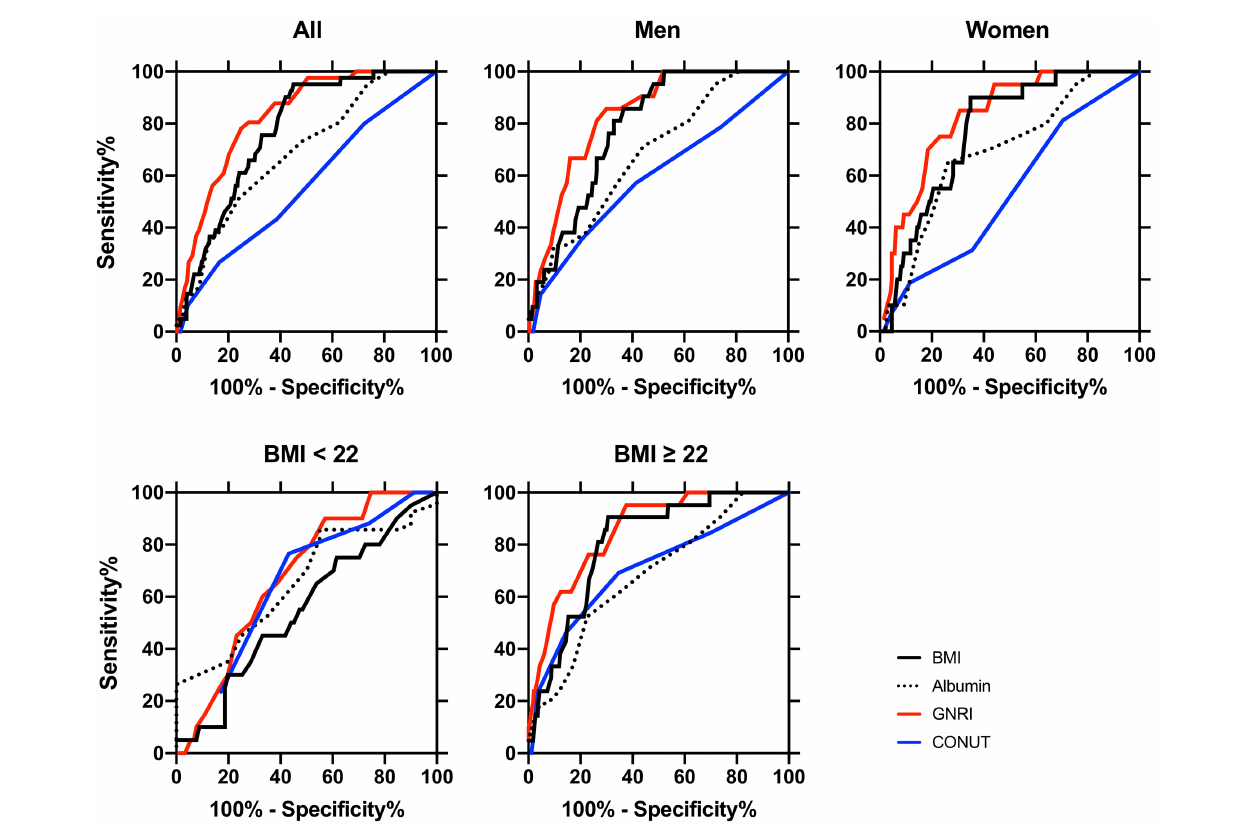
FIGURE2 Receiver-operating characteristic (ROC) curves of the nutritional indexes for distinguishing between sarcopenia ( n = 41) and non-sarcopenia ( n = 438) patients in all participants ( n = 479), in men ( n = 264), in women ( n = 215), BMI < 22 ( n = 111), and BMI ≥ 22 ( n = 368) subclasses. The area under the ROC curve (AUC) of body mass index (BMI, black lines), serum albumin (dotted lines), geriatric nutritional risk index (GNRI, red lines), and controlling nutritional status (CONUT, blue lines) were calculated for detecting diagnosis of sarcopenia, and statistical significance between AUC is shown in Table 3. The cut-off values, sensitivity, and specificity of these indices are also shown in Table 3. The definition and diagnosis of sarcopenia were based on the Asian Working Group for Sarcopenia (AWGS): 2019 Consensus Update on Sarcopenia Diagnosis and Treatment